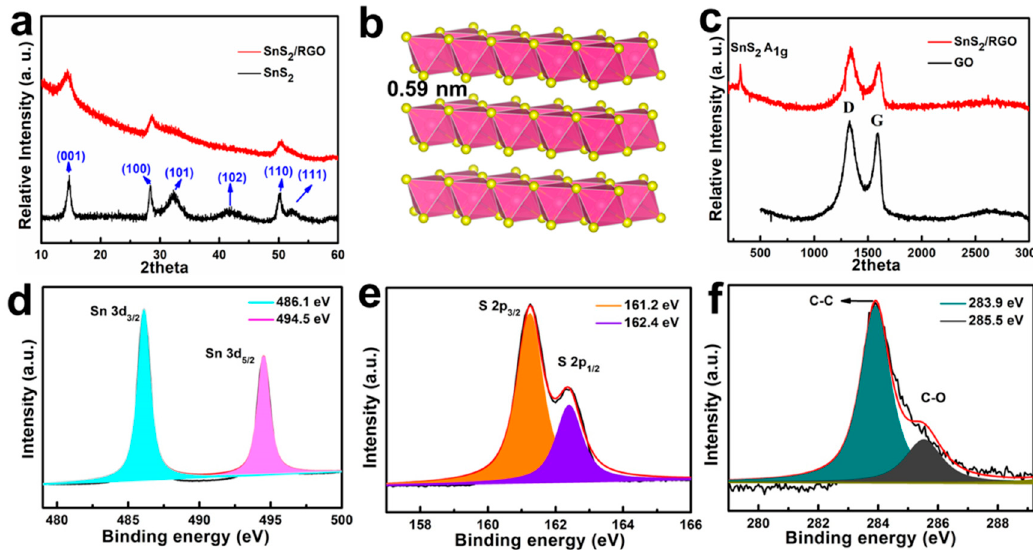
Figure 3. ( a ) XRD patterns of the obtained SnS 2 /RGO and SnS 2 . ( b ) Crystal structure of SnS 2 . ( c ) Raman spectra of SnS 2 /RGO and GO. The high-resolution XPS spectra of Sn 3d ( d ), S 2p ( e ), and ( f ) C 1s of SnS 2 /RGO.